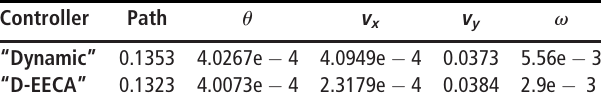
Table II RMSE of States tracking of vehicle Controller